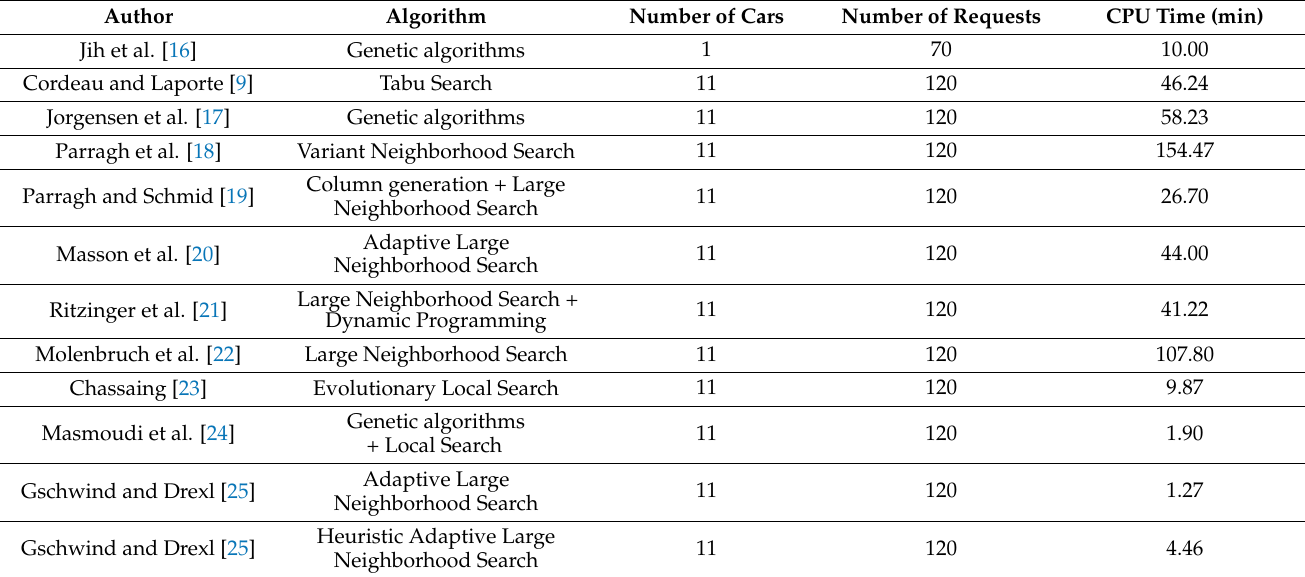
Table 1. Computation time of existing algorithms for Dial-a-Ride problems.